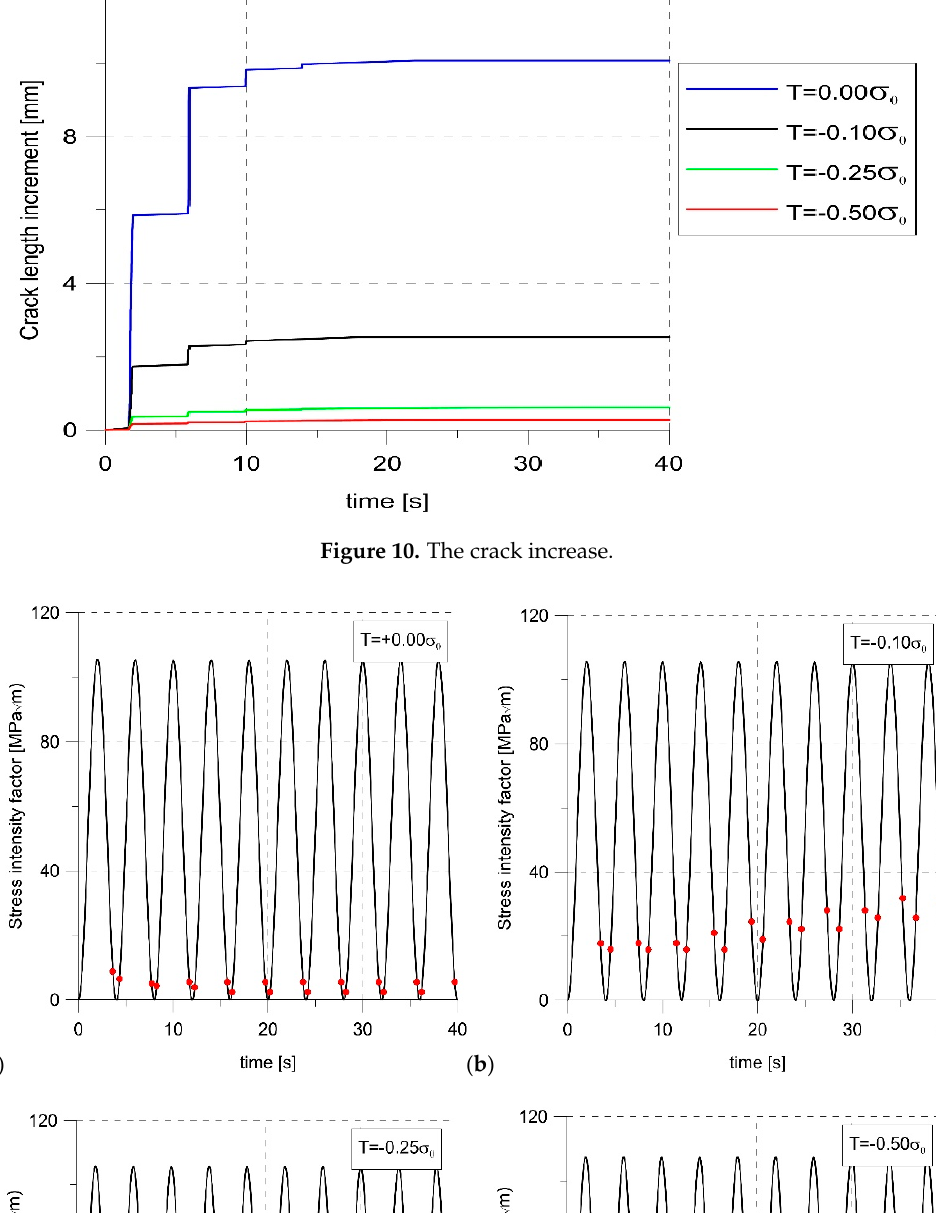
. Figure 9 . Changes in the opening stress ( a ) and COD ( b ) with load for node 1006. The constraints not only affected the level of the opening stress and the size of the opening. As can be seen in Figure 10, the highest crack growth rate was obtained for T=0. The lower the constraint level, the shorter crack increase was obtained. To determine the